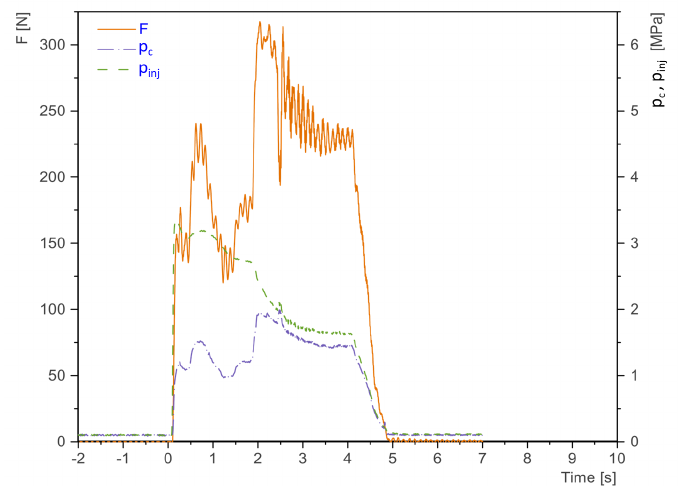
Figure 18. Data of an engine test of the rotated star shape with 2 s of burn time.